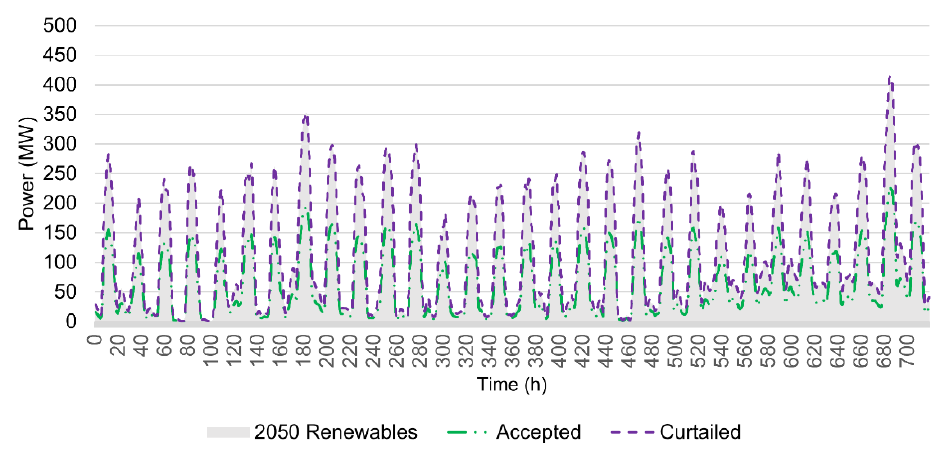
Mathematics 2019 , 7 , x FOR PEER REVIEW Figure 12. 2050 renewable levels accepted and curtailed for Case 3. Figure 12. 2050 renewable levels accepted and curtailed for Case 3.